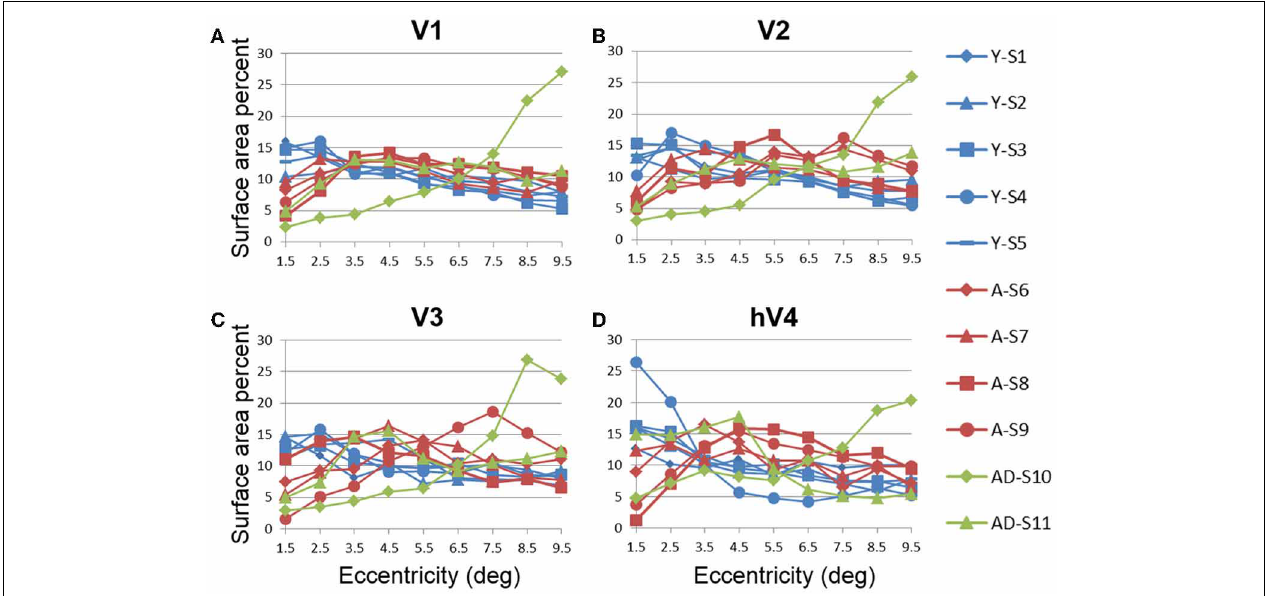
FIGURE 4 | Surface area percent distribution measurements for visual field maps in individual young, healthy aging, and mild Alzheimer’s disease subjects. (A) V1. (B) V2. (C) V3. (D) hV4. Blue lines represent data from healthy young subjects, red lines represent data from healthy aging subjects, and green lines represent data from mild AD subjects. Each line